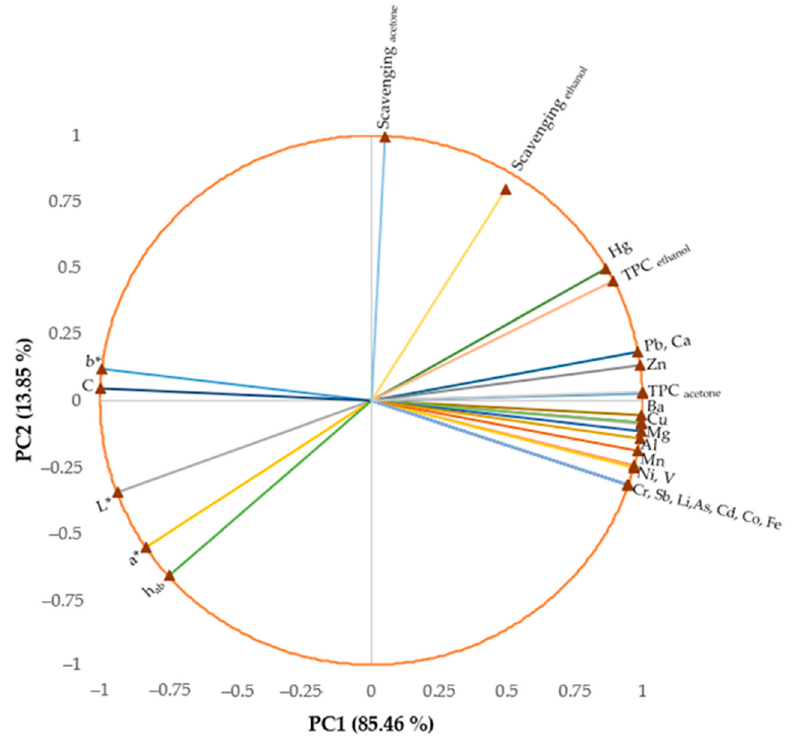
Figure 7. The Principal Components Analysis (PCA) plot.